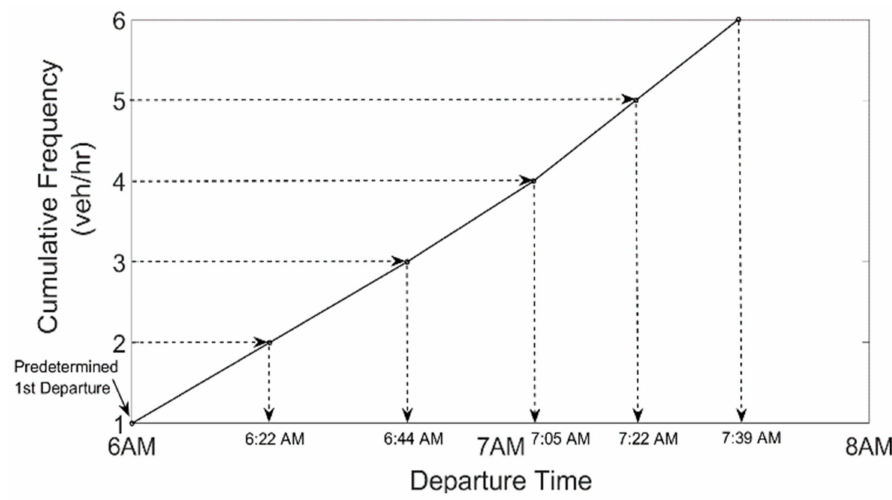
Figure 5. Determination of departure times using the graphical method in